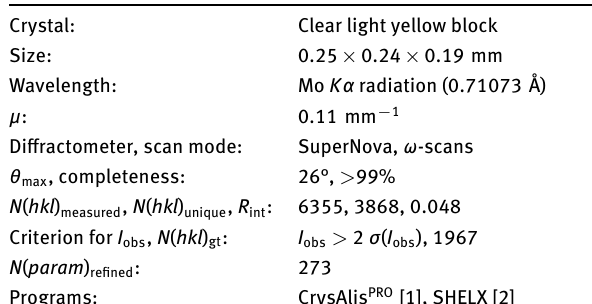
Table 1: Data collection and handling.